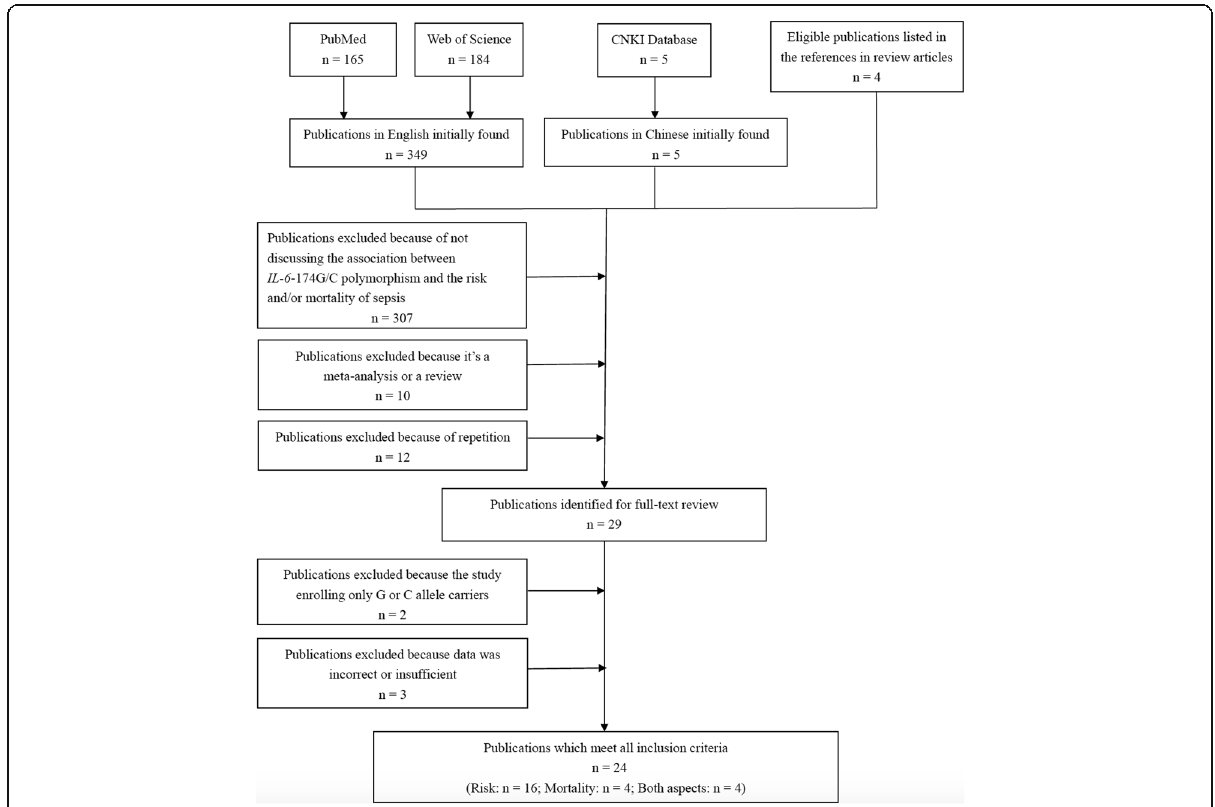
Fig. 1 Flow diagram of the study selection